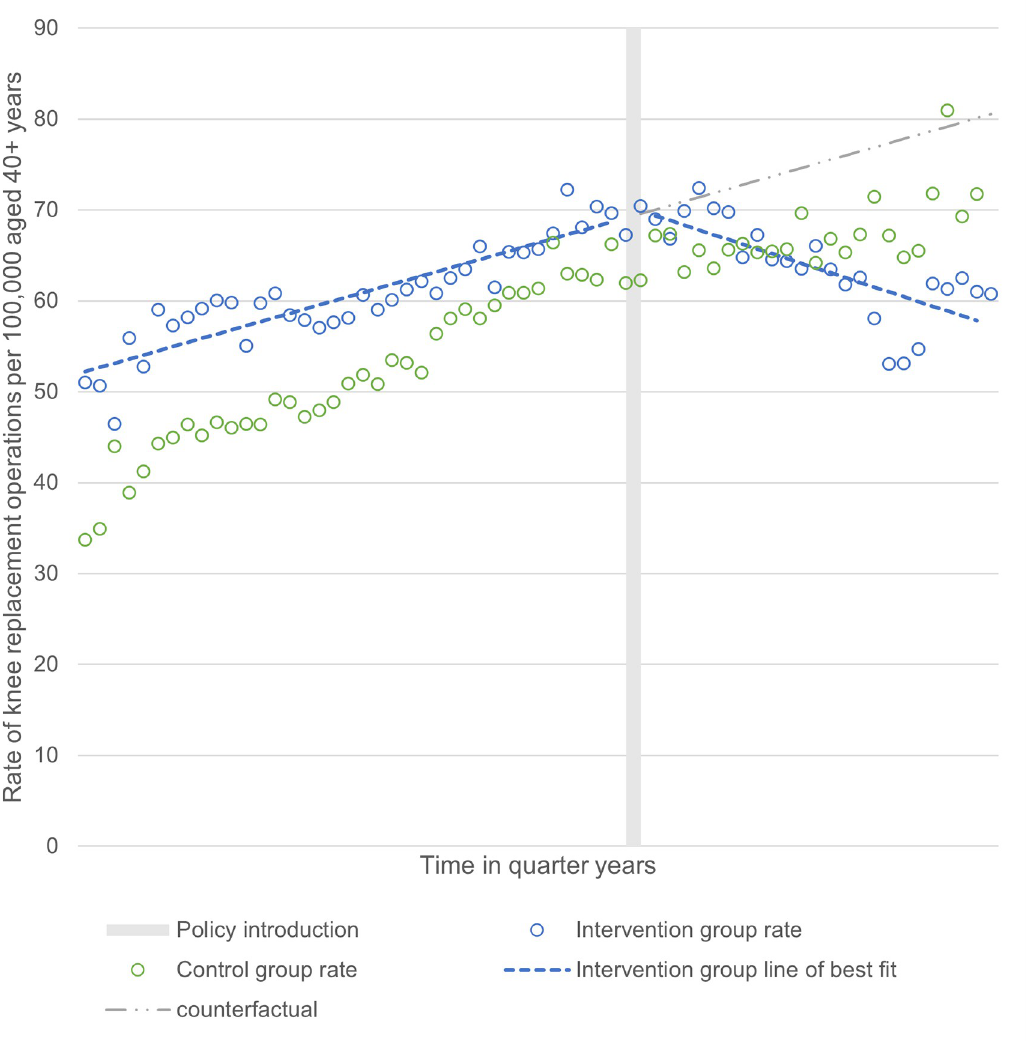
Fig 3. Interrupted time series analyses of rate of knee replacement surgery per 100,000 population aged 40+ from pooled data for all intervention and control CCGs (n = 130).